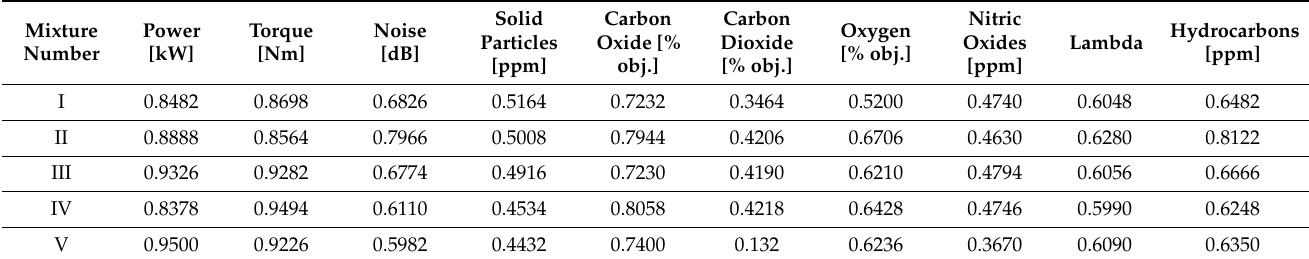
Table 6. Assessment of the values of performance parameters for particular mixtures of diesel fuel and fatty acid methyl esters.